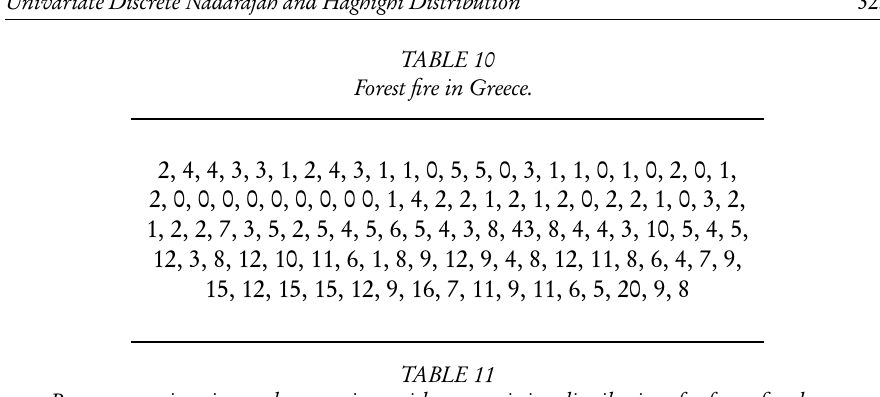
Parameter estimation and comparison with some existing distributions for forest fire data. Model